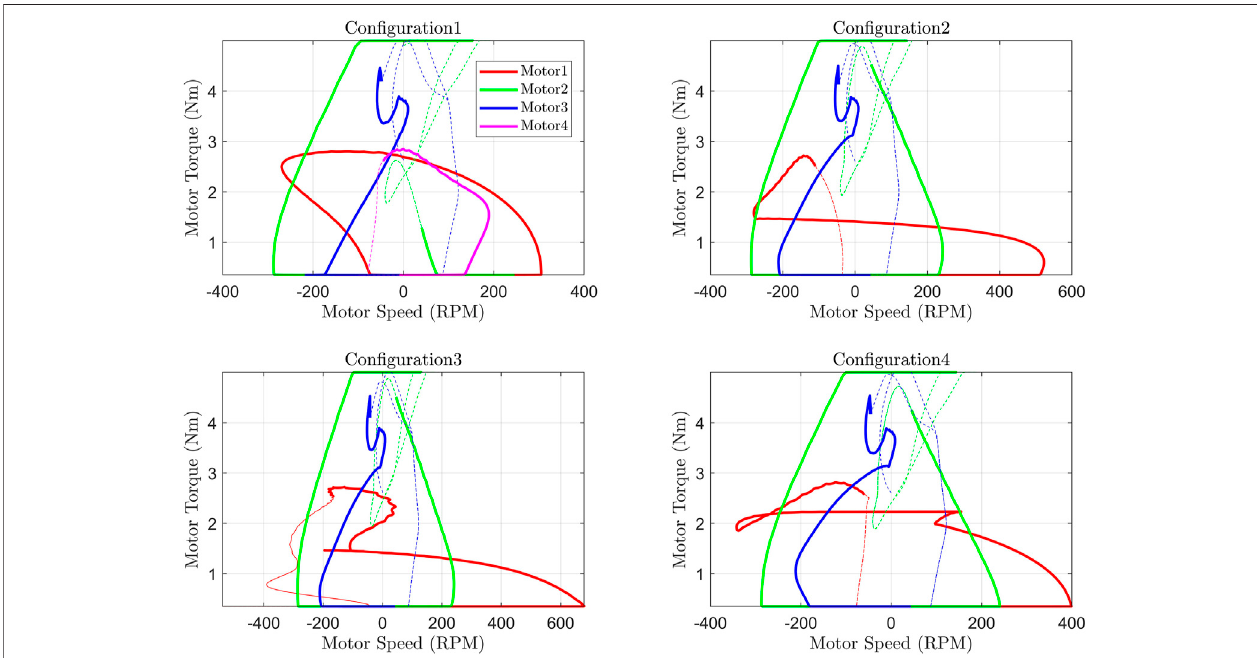
FIGURE 9 | Motor torque versus speed